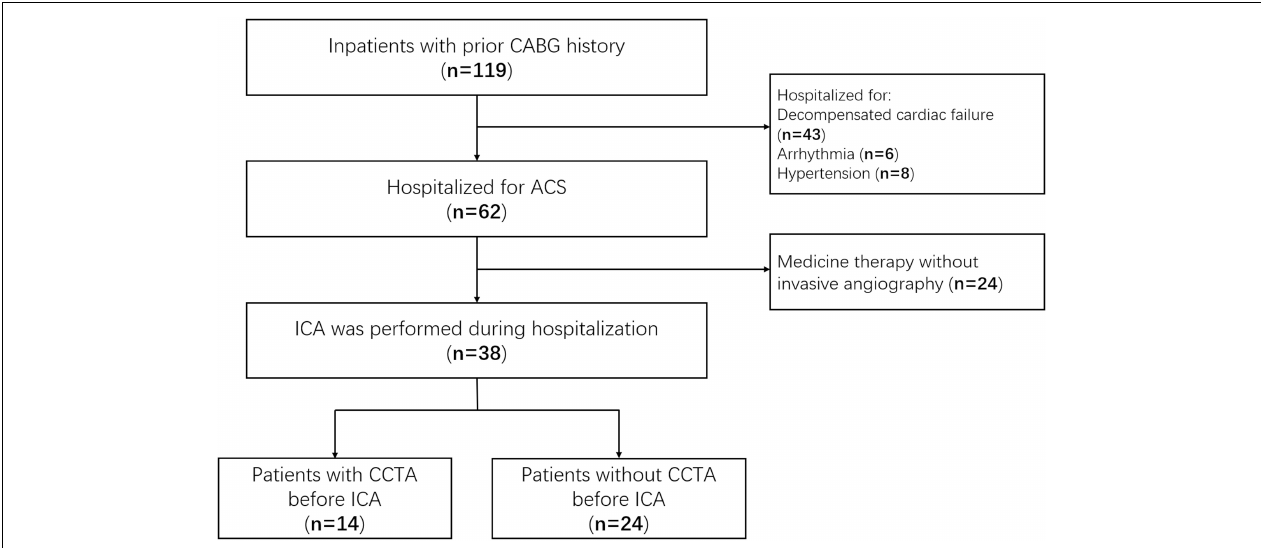
FIGURE 2 | Study flow diagram. CABG, coronary artery bypass grafting; ACS, acute coronary syndrome; ICA, invasive coronary angiography; CCTA, coronary computed tomographic